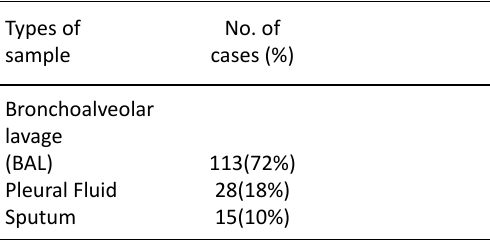
table 1. Sample wise distribution of suspected cases of tuberculosis (n=156 )